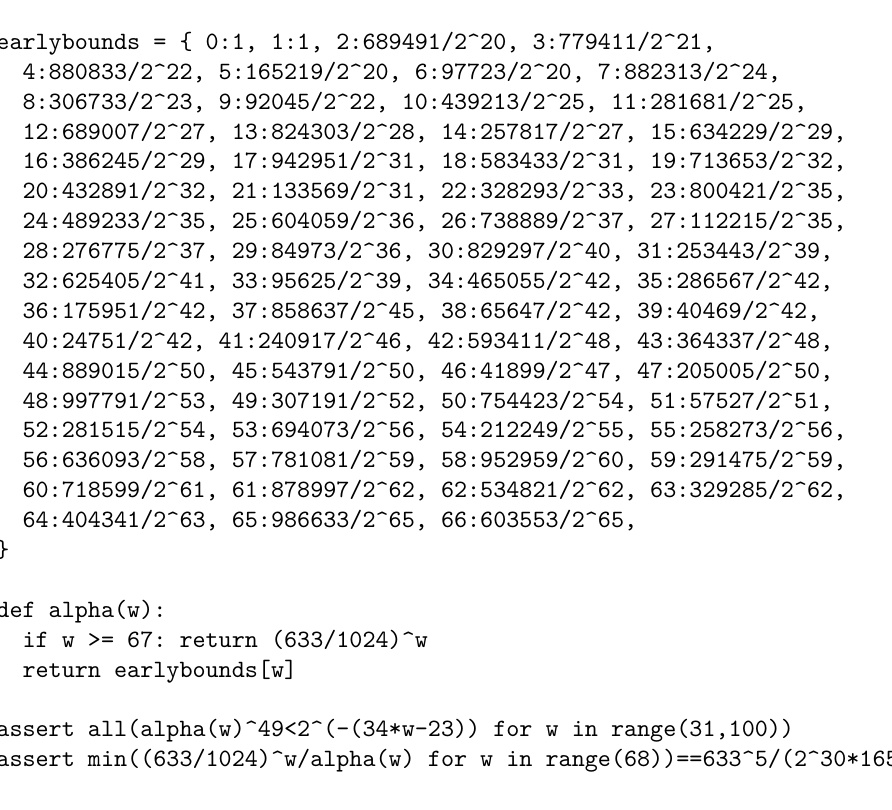
Figure F.14: Definition of α w for w ∈ { 0 , 1 , 2 , . . . } ; computer